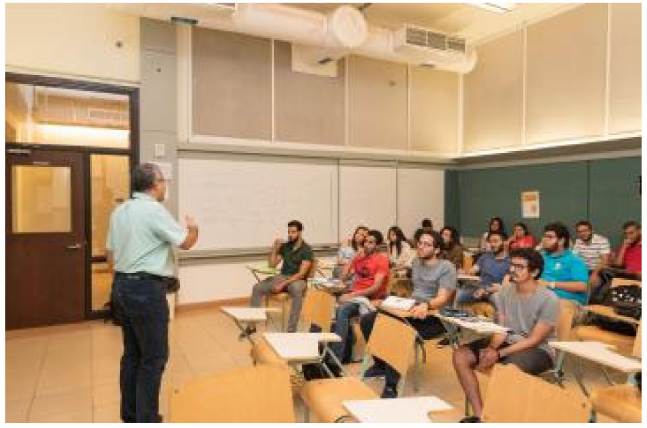
Figure 1. Standard Classroom at the American University in Cairo. Courtesy of